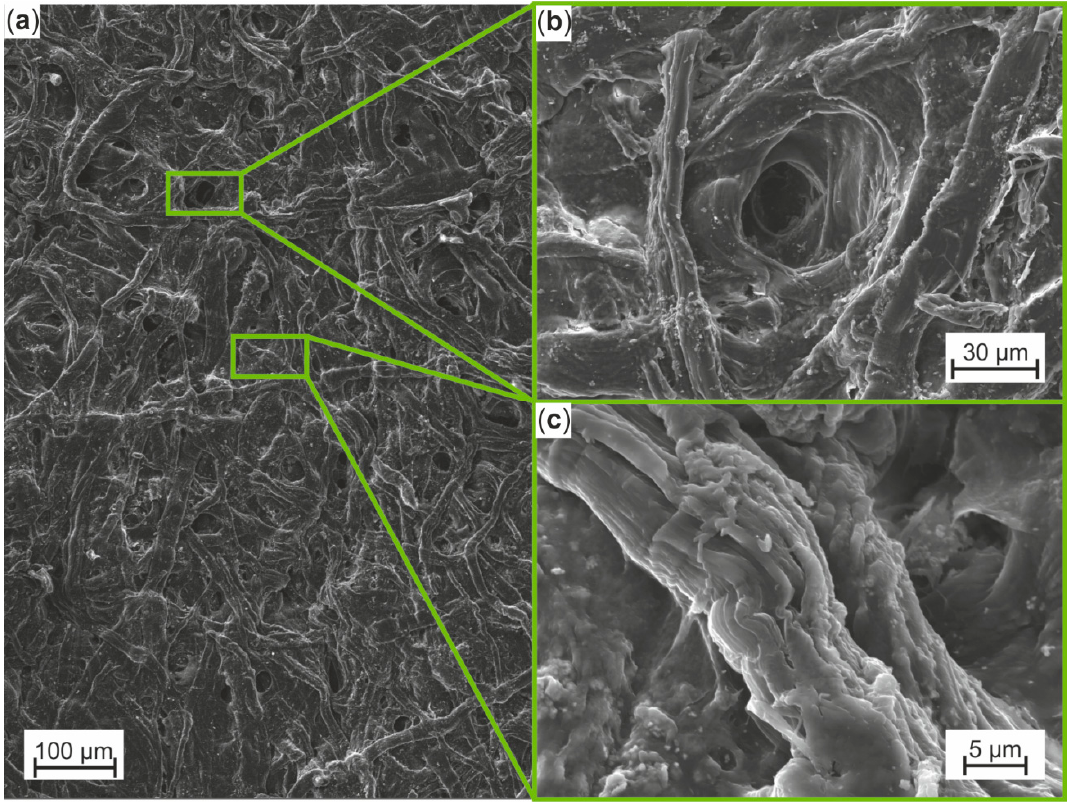
Figure 6. SEM micrographs of Cottonid’s surface for identification of characteristic surface defects in initial condition: ( a ) field of view in in situ test; ( b ) pore; and ( c ) single fiber.